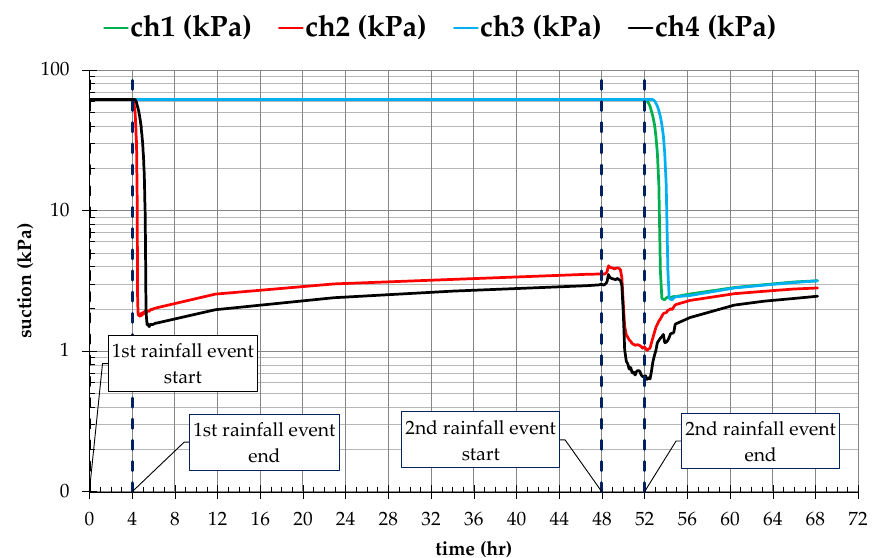
Figure 9. Logged time matric suction values at the four points of monitoring during the two infiltration stages. Labels mark the start/end time of the two main rainfall events.